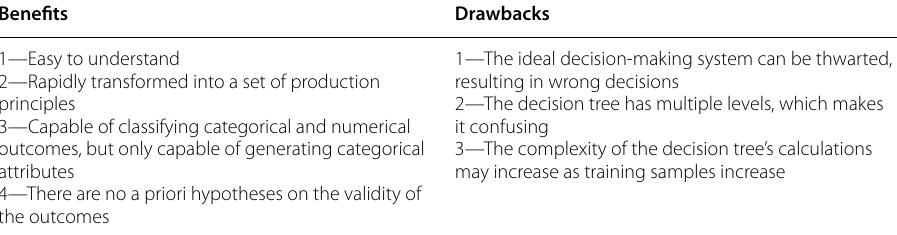
Table 1 DT benefits and drawbacks Benefits